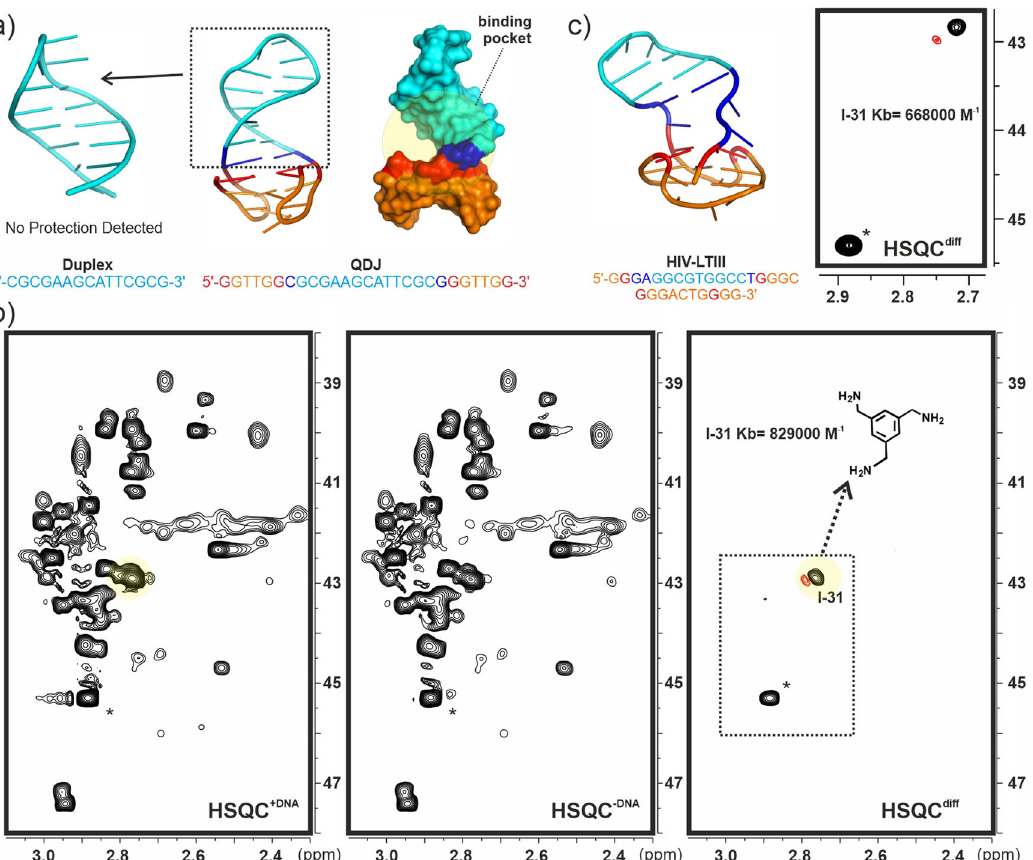
Fig. 7 Protection assays with DNA quadruplex-duplex junctions. a Structure of the simple B-DNA duplex and model quadruplex-duplex junction (QDJ) employed in our assays. b Protection experiments performed employing the complete 53-compound library in the presence of the QDJ fragment. HSQC + DNA , HSQC − DNA and HSQC diff data sets (pH 7.2) are represented. c Protection experiment performed with the HIV-LTIII fragment (above). A section of the resulting HSQC diff data set is represented.